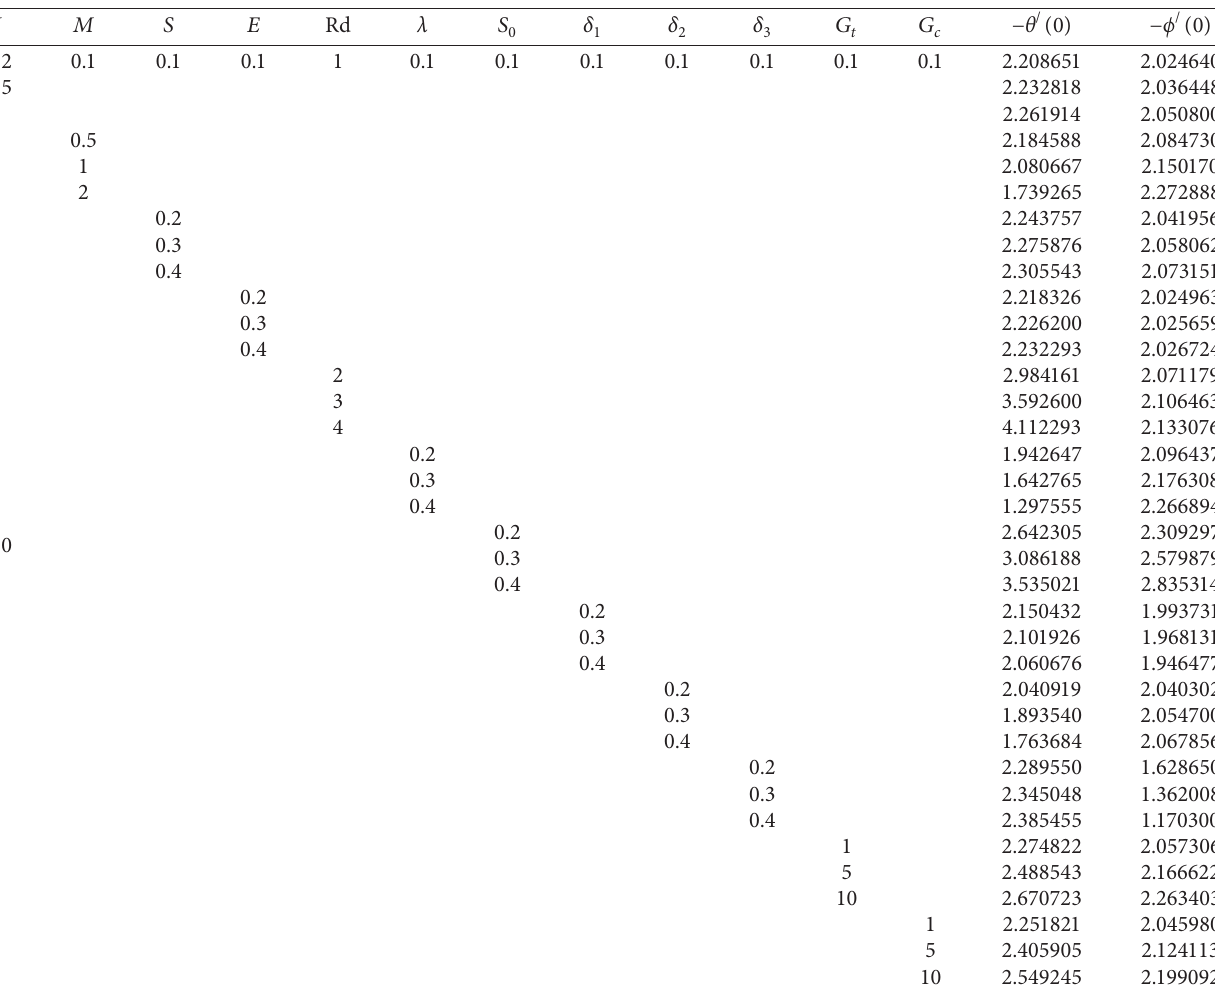
Table 2: Numerical values of − θ ′ ( 0 ) and − ϕ ′ ( 0 ) with Pr � 10 and Sc �